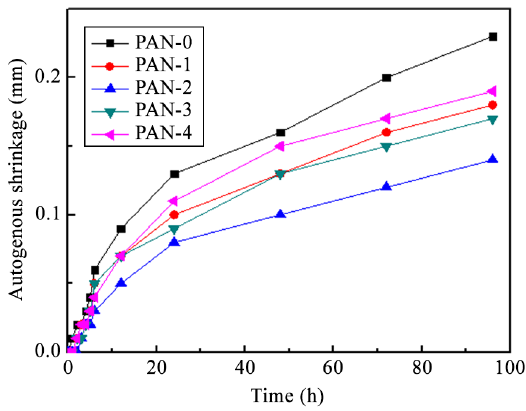
Figure 1. Autogenous shrinkage performance of PAN fiber reinforced concrete.